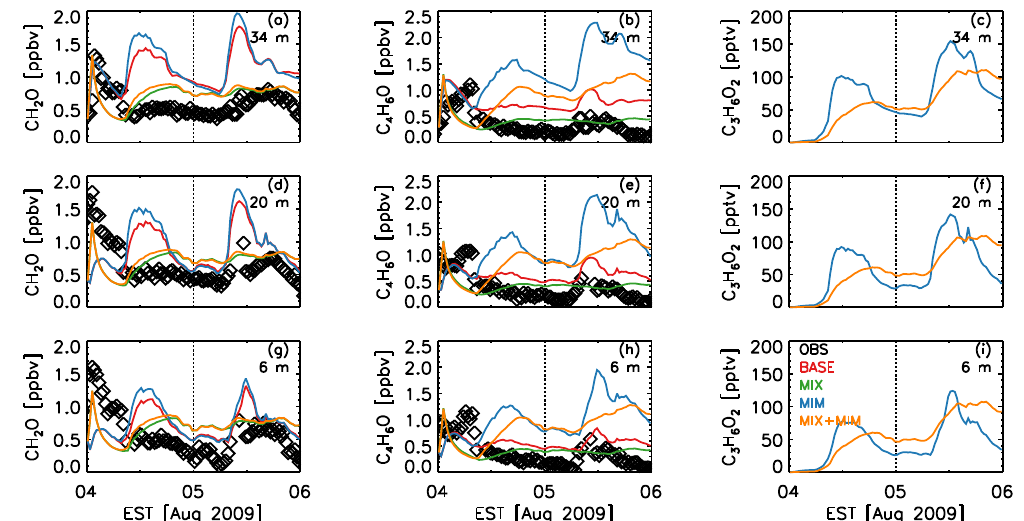
Fig. 8. Same as Fig. 5, but for (a, d, g) formaldehyde, (b, e, h) MACR+MVK, and (c, f, i) hydroxyacetone. Observations of hydroxyacetone are not available.